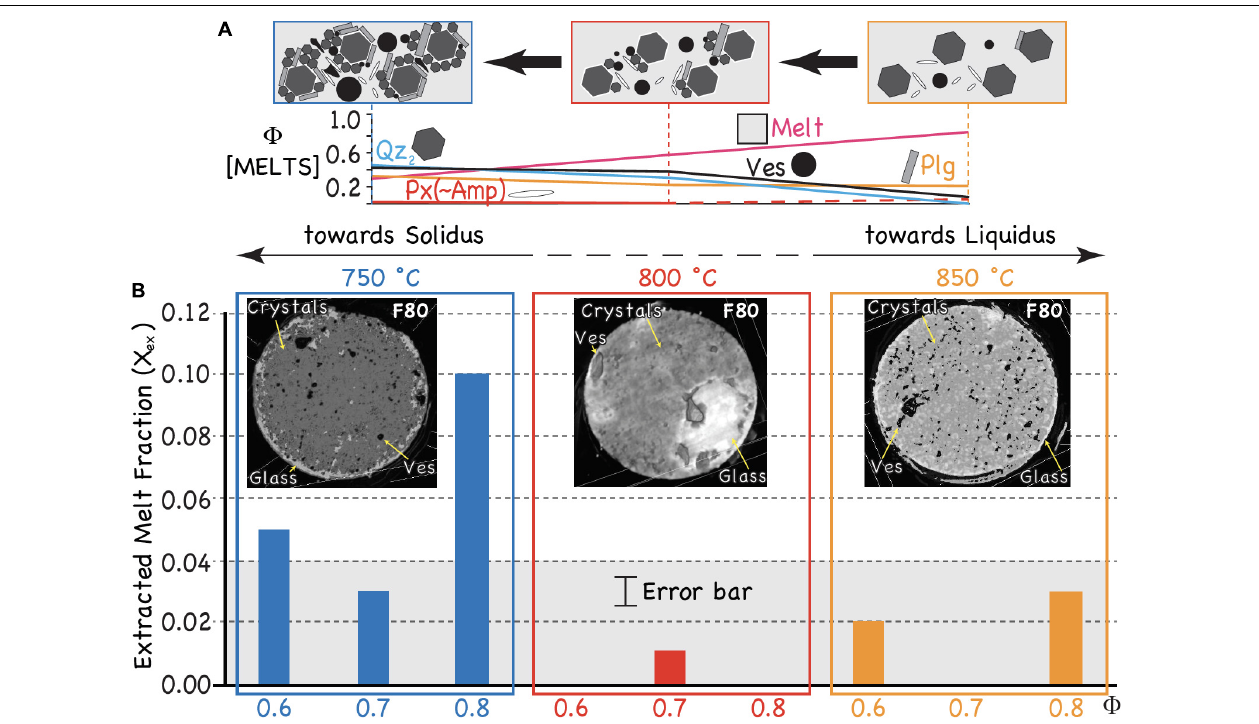
FIGURE 8 | (A) Volume fraction variation of the major phases at different T , based on crystallization simulations using Rhyolite-MELTS. (B) Extracted melt fraction ( X ex ) as a function of T and (cid:56) , with representative X-ray tomographic projections (6 µ m/pixel spatial resolution; top-viewed) taken in the middle portion of each sample that show the distribution of glass (light gray), vesicles (black), and crystals (dark gray). The gray area indicates the volume fractions of residual rhyolitic melt observed in natural enclaves in volcanic rocks (after Bacon,